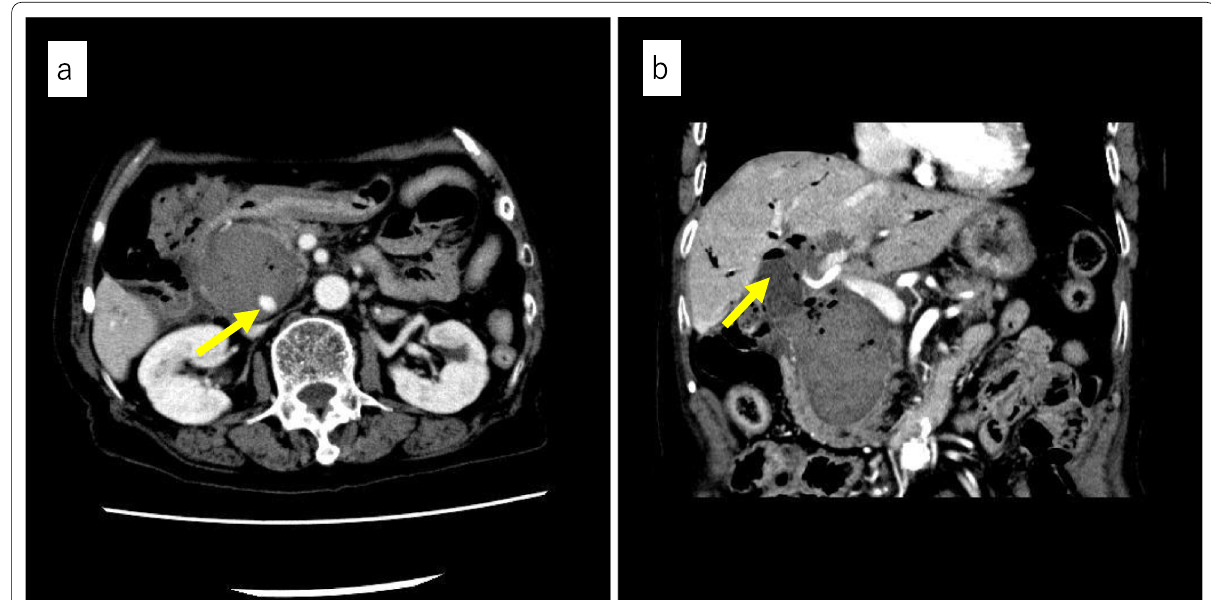
Fig. 1 Preoperative enhanced CT findings. a Transverse image. Contents of the cystic lesion of the pancreatic head reveal a relatively high CT number. An arrow shows pseudoaneurysm in the cystic lesion. b Coronal image. The gallbladder had been resected. An arrow shows the suspicious structure of the elevated jejunum adjacent to the gallbladder